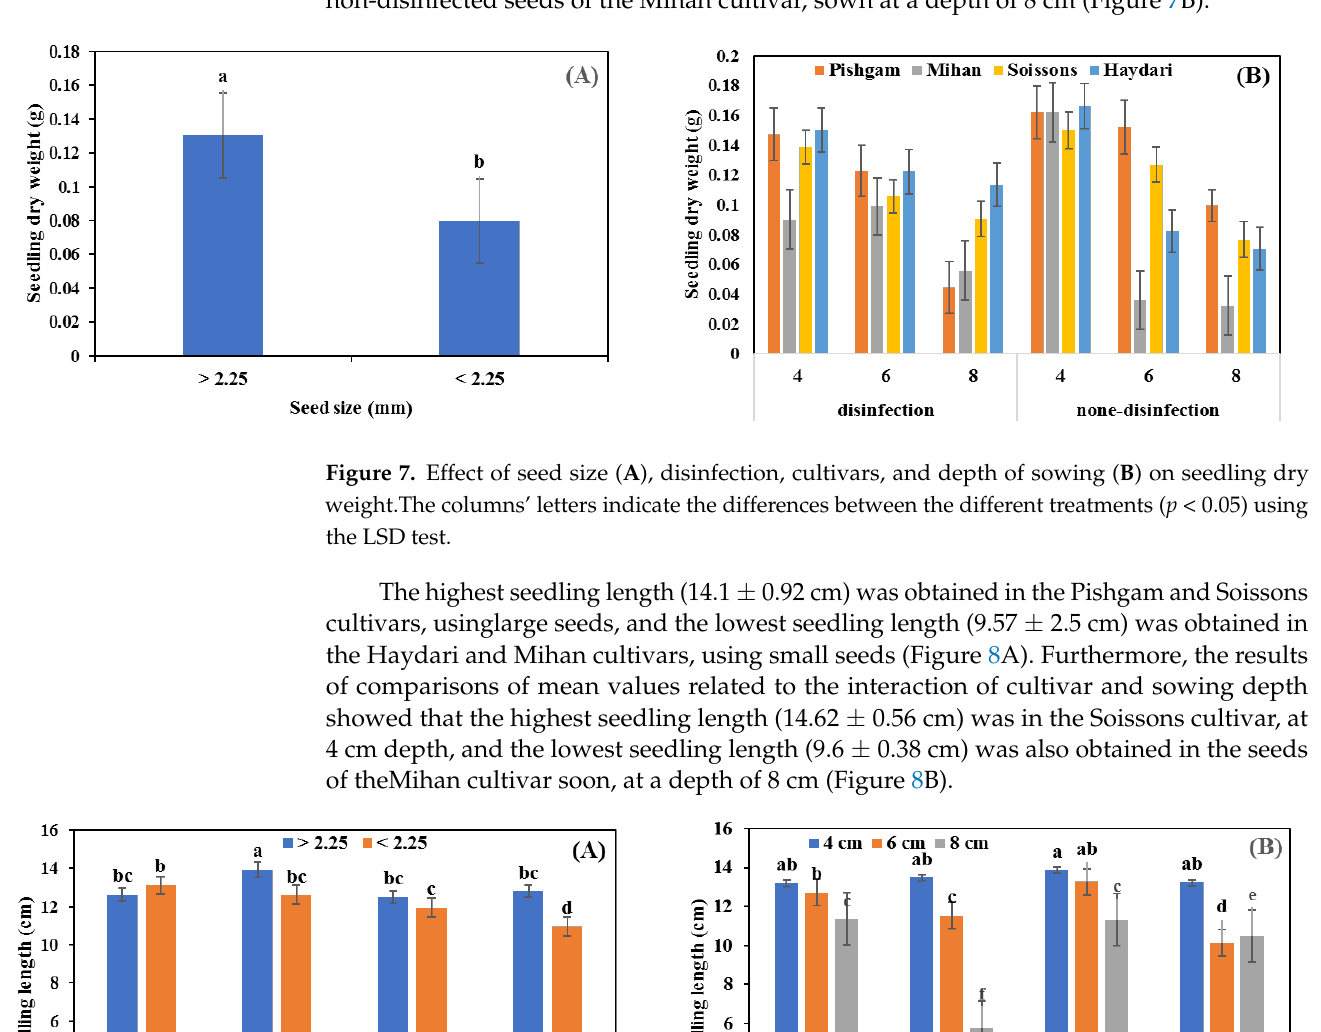
Table 4. Effect of depth of sowing, disinfection, and seed size upon the percentage of germination, speed of seed germination, and vigor index in different cultivars.